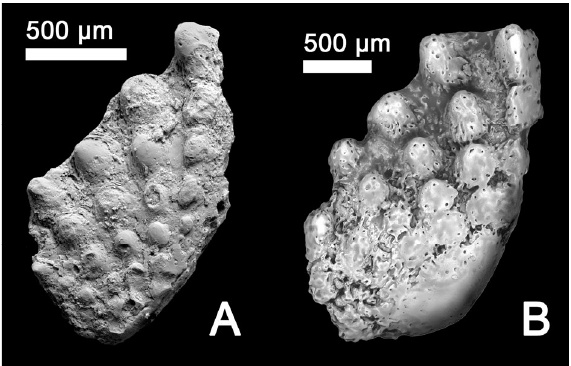
Fig. 6. Prearticular tooth plates of the juvenile dipnoan fishes cf. Andreyevichthys sp. Lipetsk Region, Central Russia, right bank of the Rykhotka River (right tributary of the Don River), a local quarry approximately 100 m north of the Voskresenskoye village. A , PIN 2921/3281; B , PIN 2921/3284, occlusal